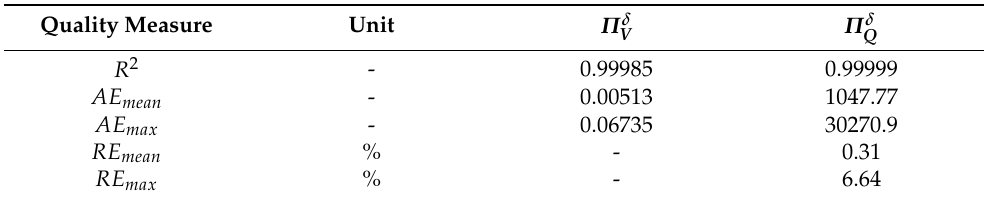
(cid:17) (cid:16) = f t / D b , n , Π δ p , x and Π δ Q